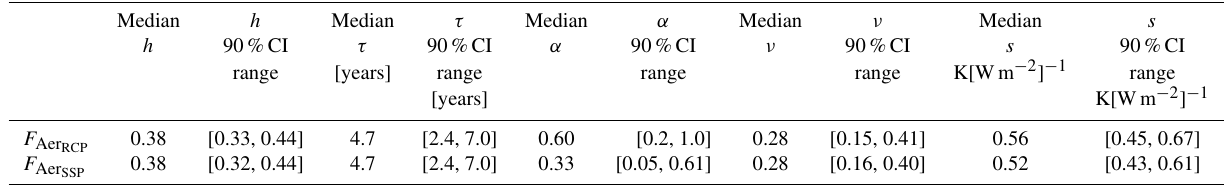
Table 1. Model and forcing parameter medians for FEBE calibrated over the historical period (1880–2020) using F Aer with their corresponding 90% credible intervals.